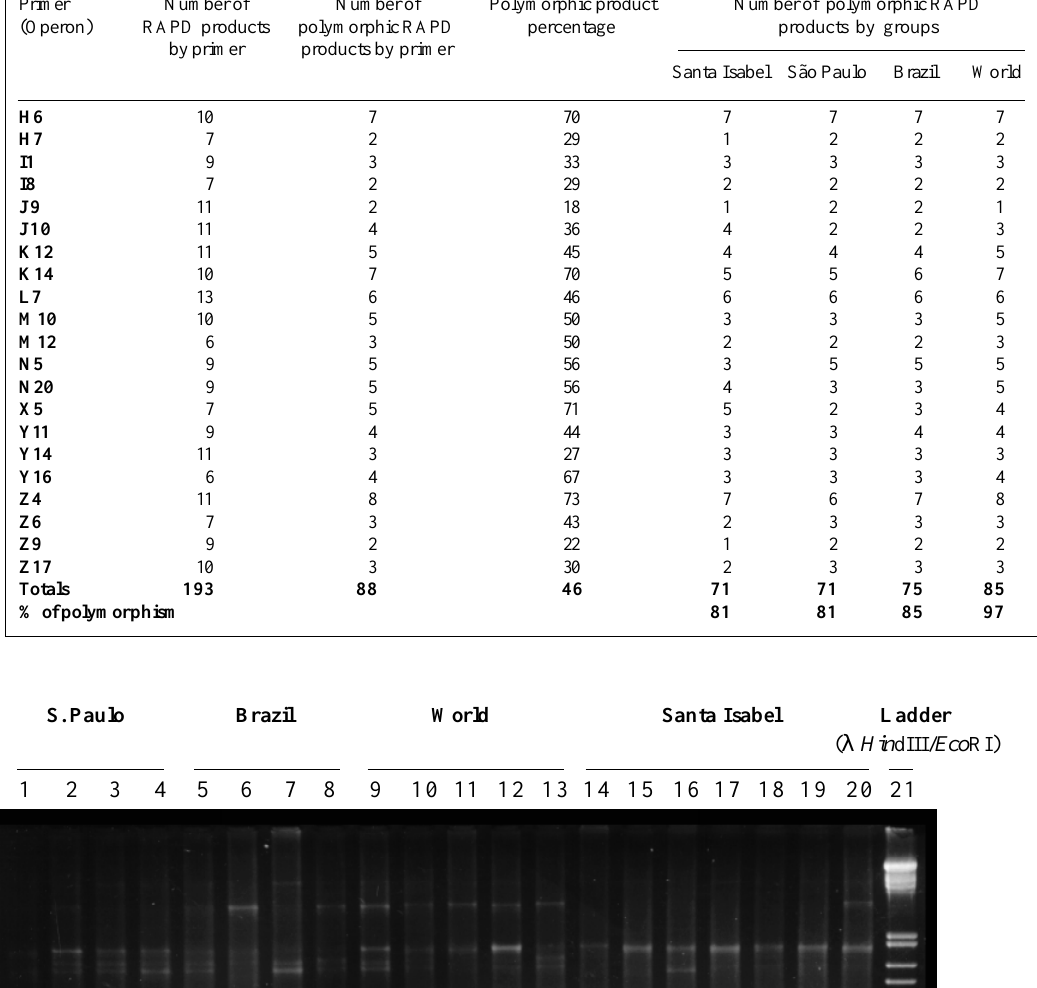
Table II - Number and frequency of RAPD polymorphism products amplified by the primer in cassava.